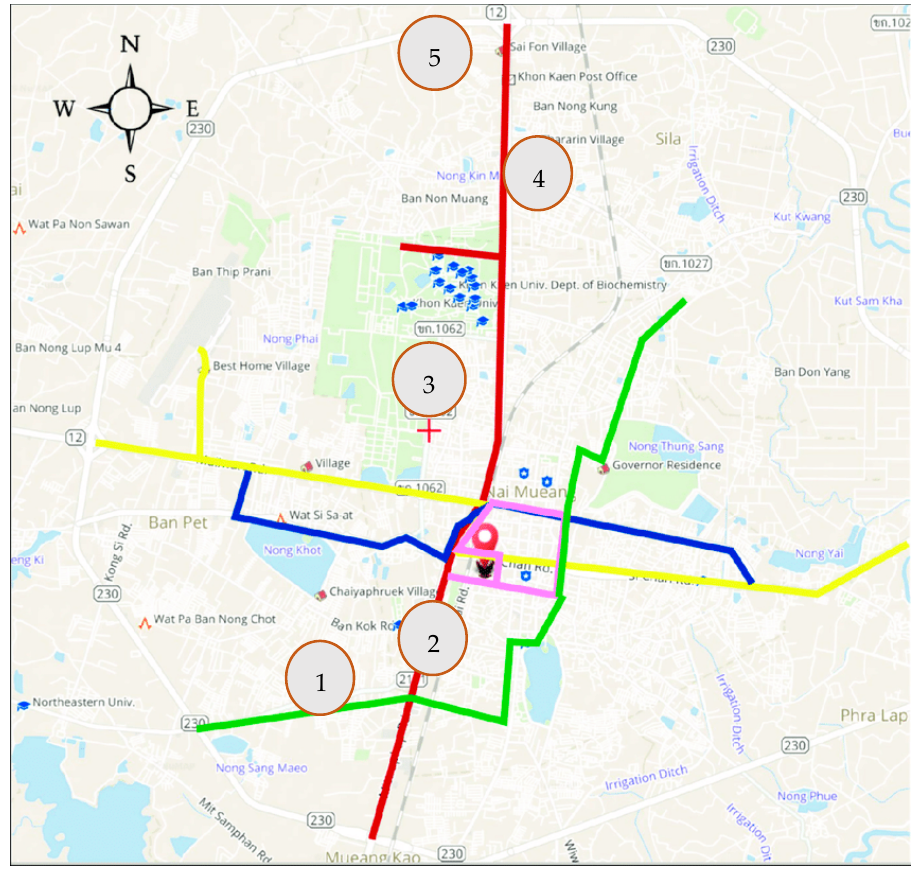
Figure 6. The visual presentation of the approved LRT route (RED line) for the KK LRT north and south line, representing 22.80 km through five municipalities numbered 1–5 (Sudhipongpracha and Dahiya